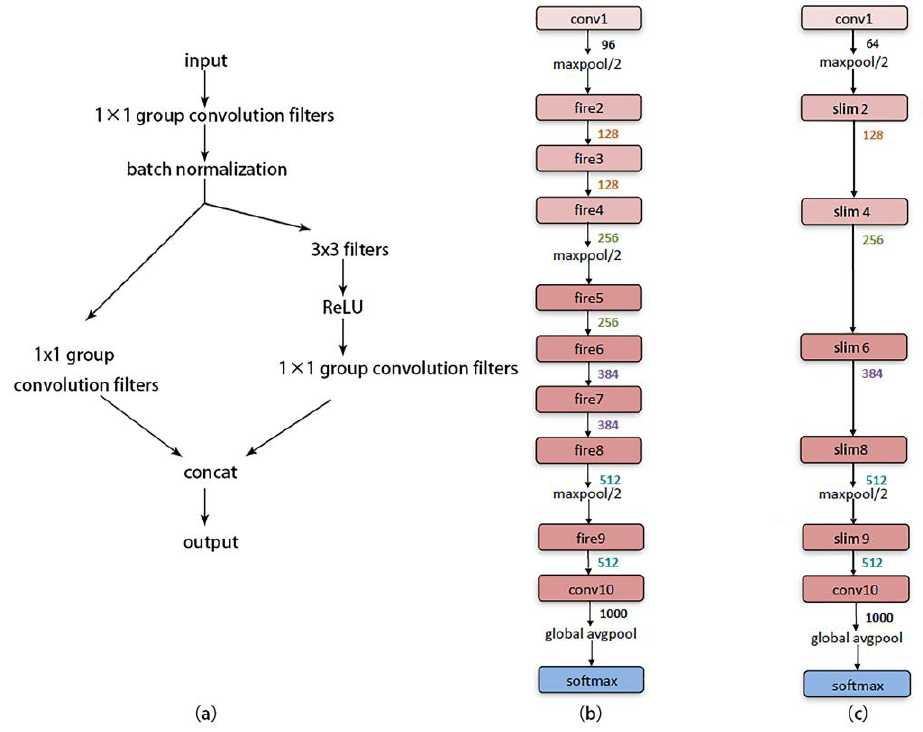
Figure 5. ( a ) Slim module [30]; ( b ) SqueezeNet [27]; ( c ) the improved model based on the Slim module structure.